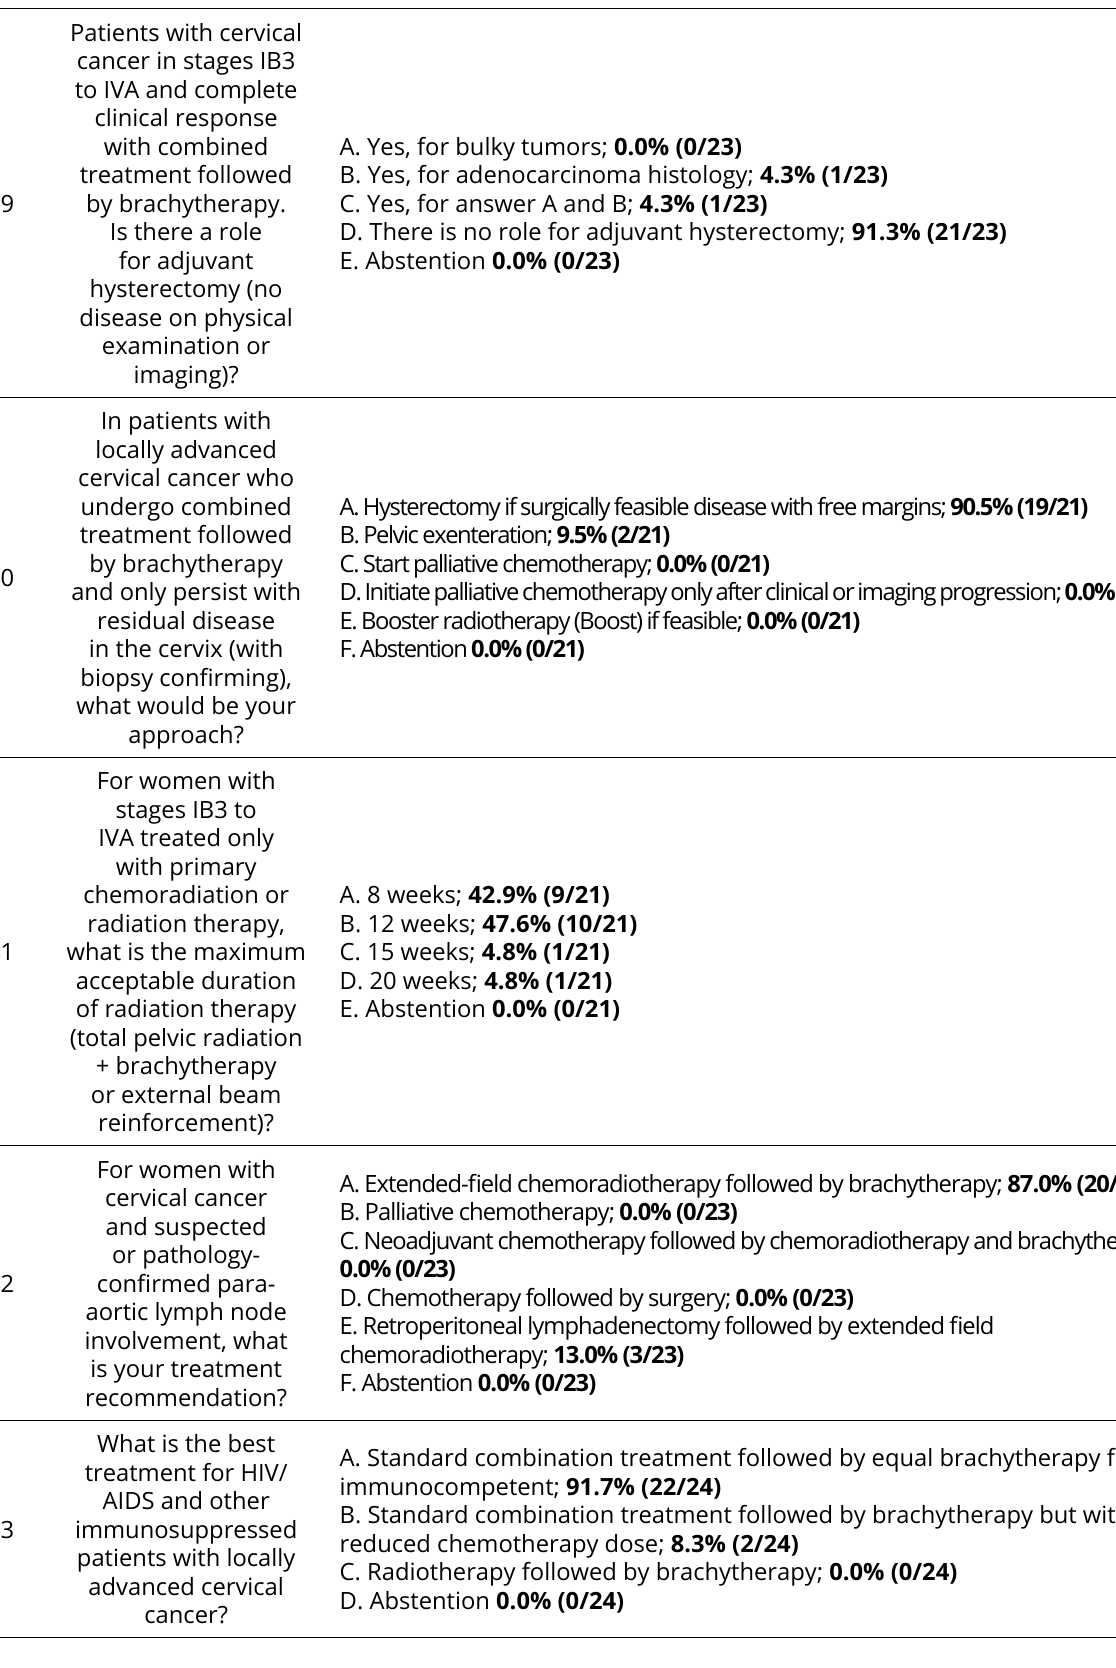
Key issues in the management of cervical cancer: consensus recommendations by a Brazilian expert panel Brazilian Journal of